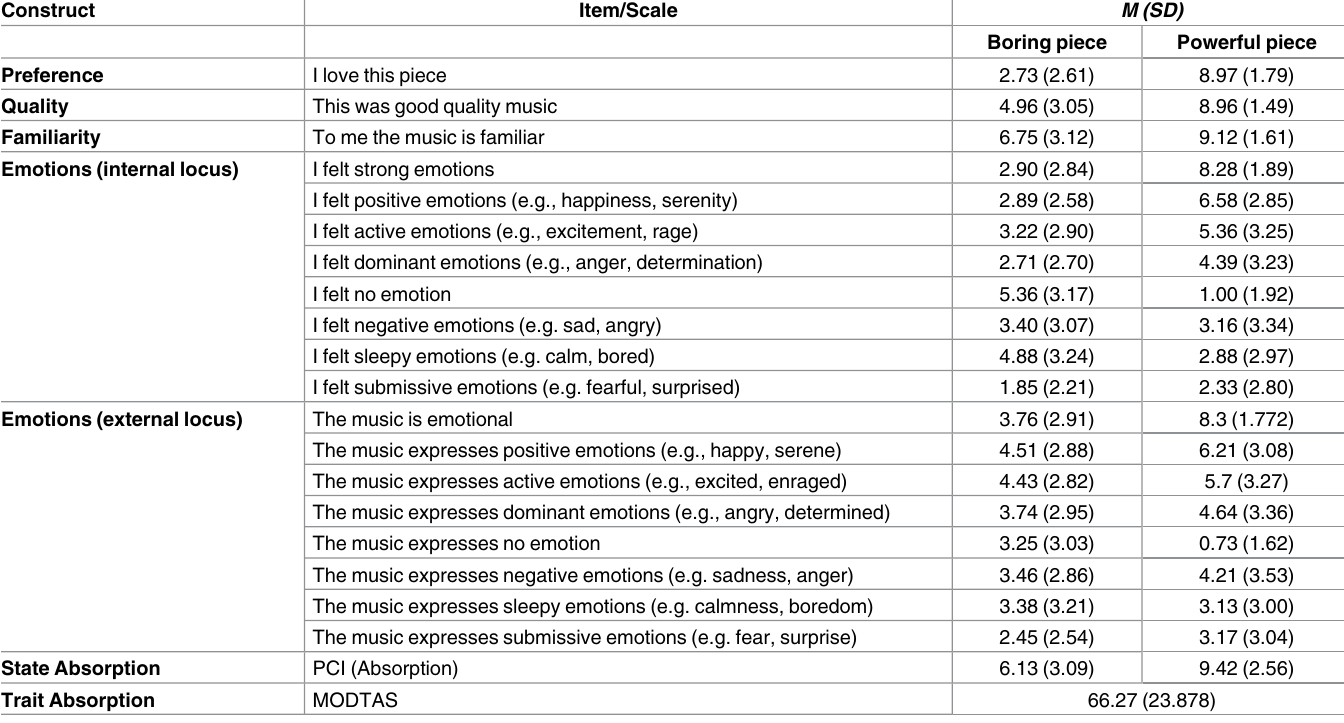
Table 1. Means and standard deviations for listening appraisal items and absorption measures.